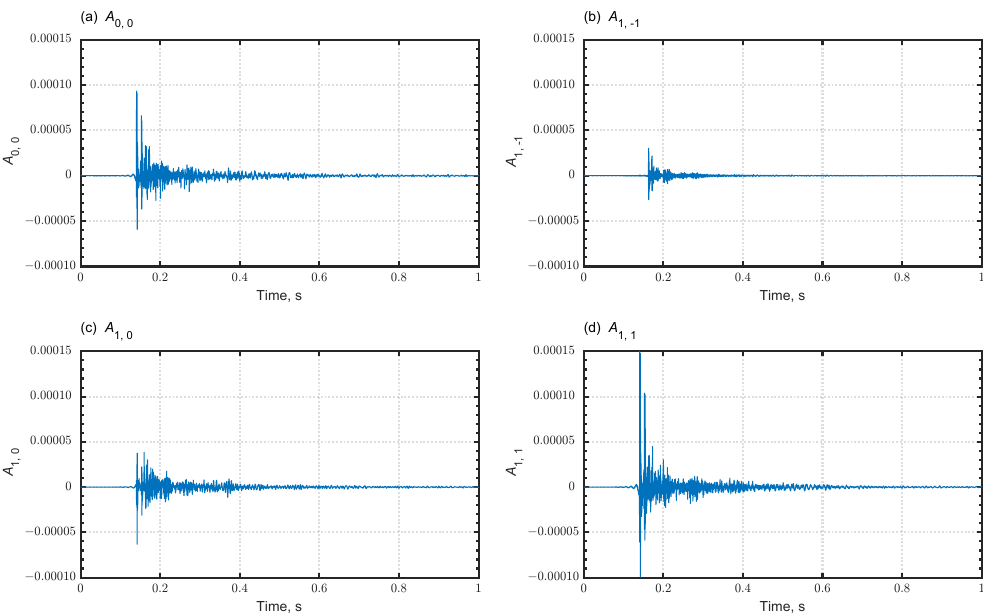
Figure 11. Simulated FOA signals at R3 in Cond. 2: ( a ) A 0,0 ; ( b ) A 1, − 1 ; ( c ) A 1,0 ; and ( d ) A 1,1 .